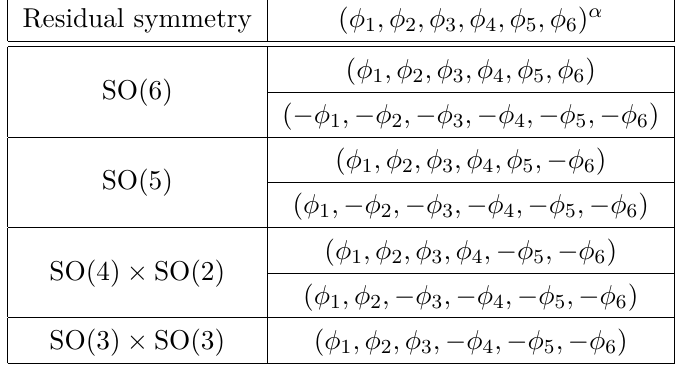
Table 1 . Crosscaps of O (6) sigma